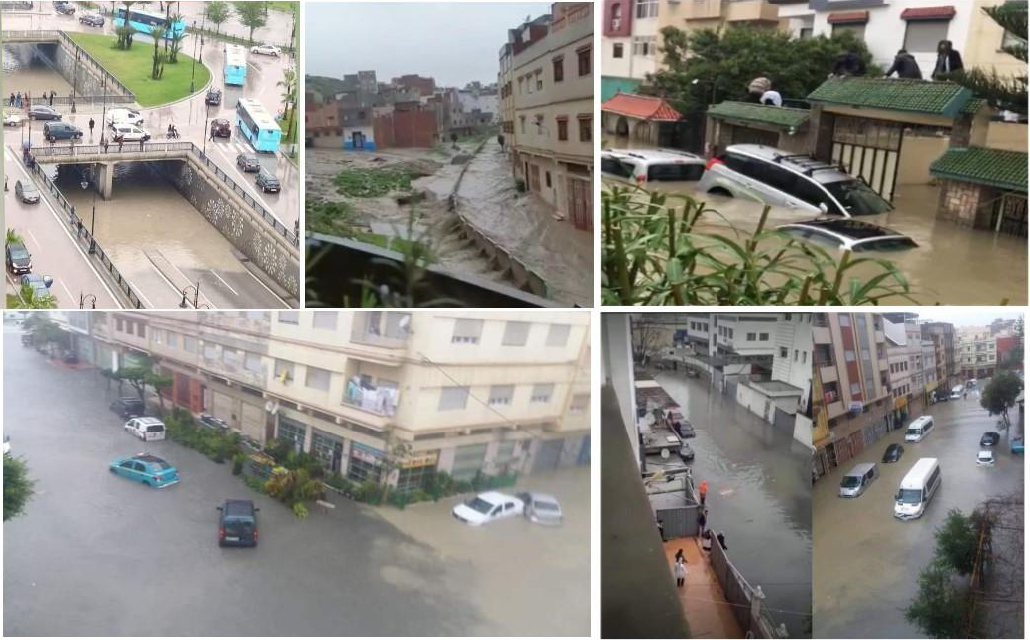
Figure 2. Flooding in Tangier city (2018 – 2021).